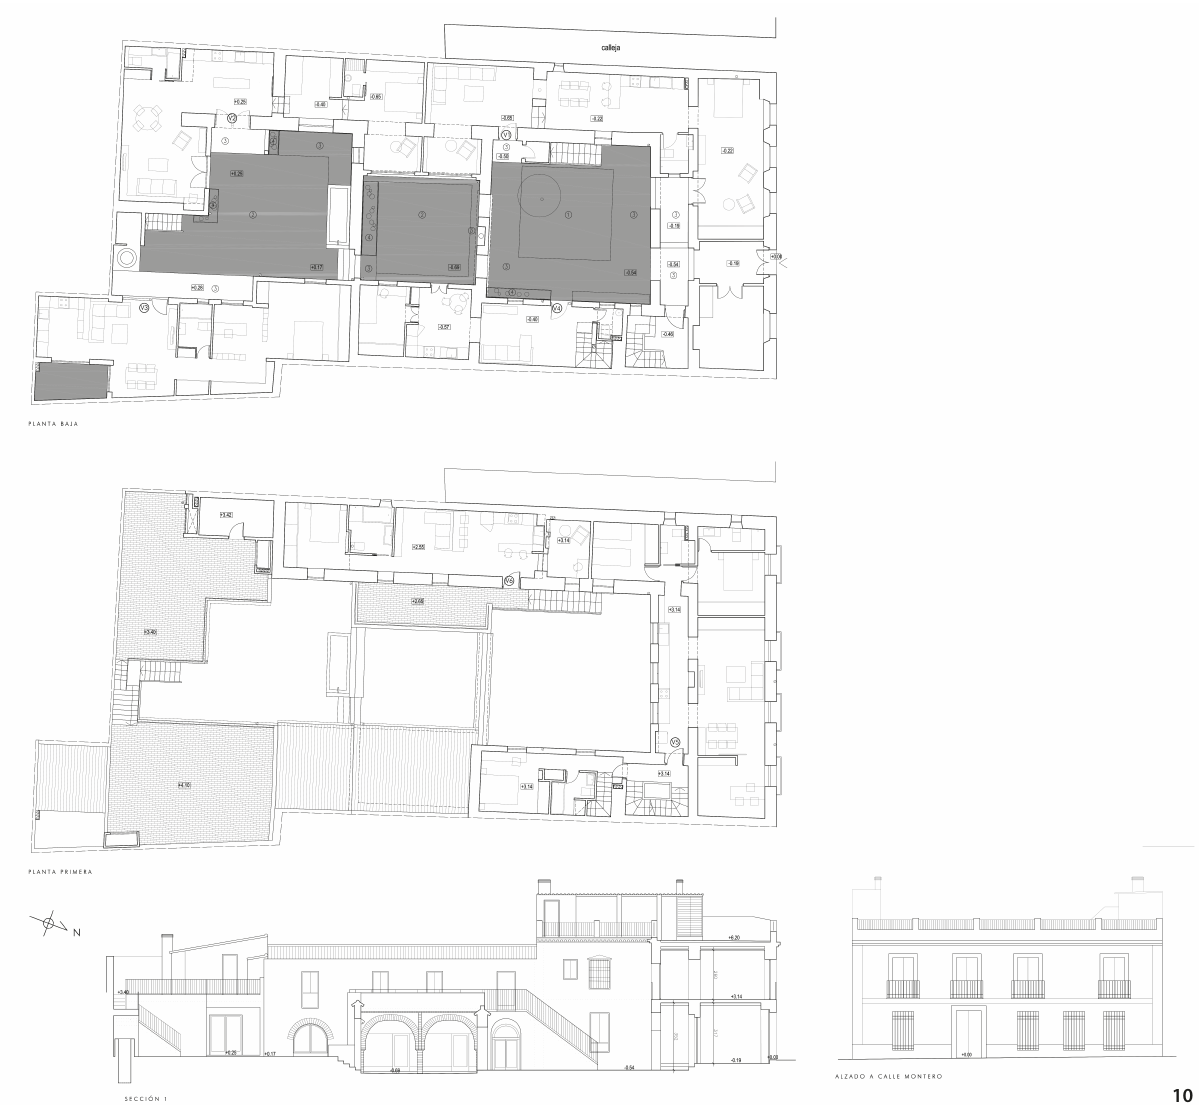
Figure 10 Plans and sections of the project of the First Pax Cooperative Montero street for 6 families (Source: Gaia Redaelli, Jacinta Ortiz, Carlos Anaya